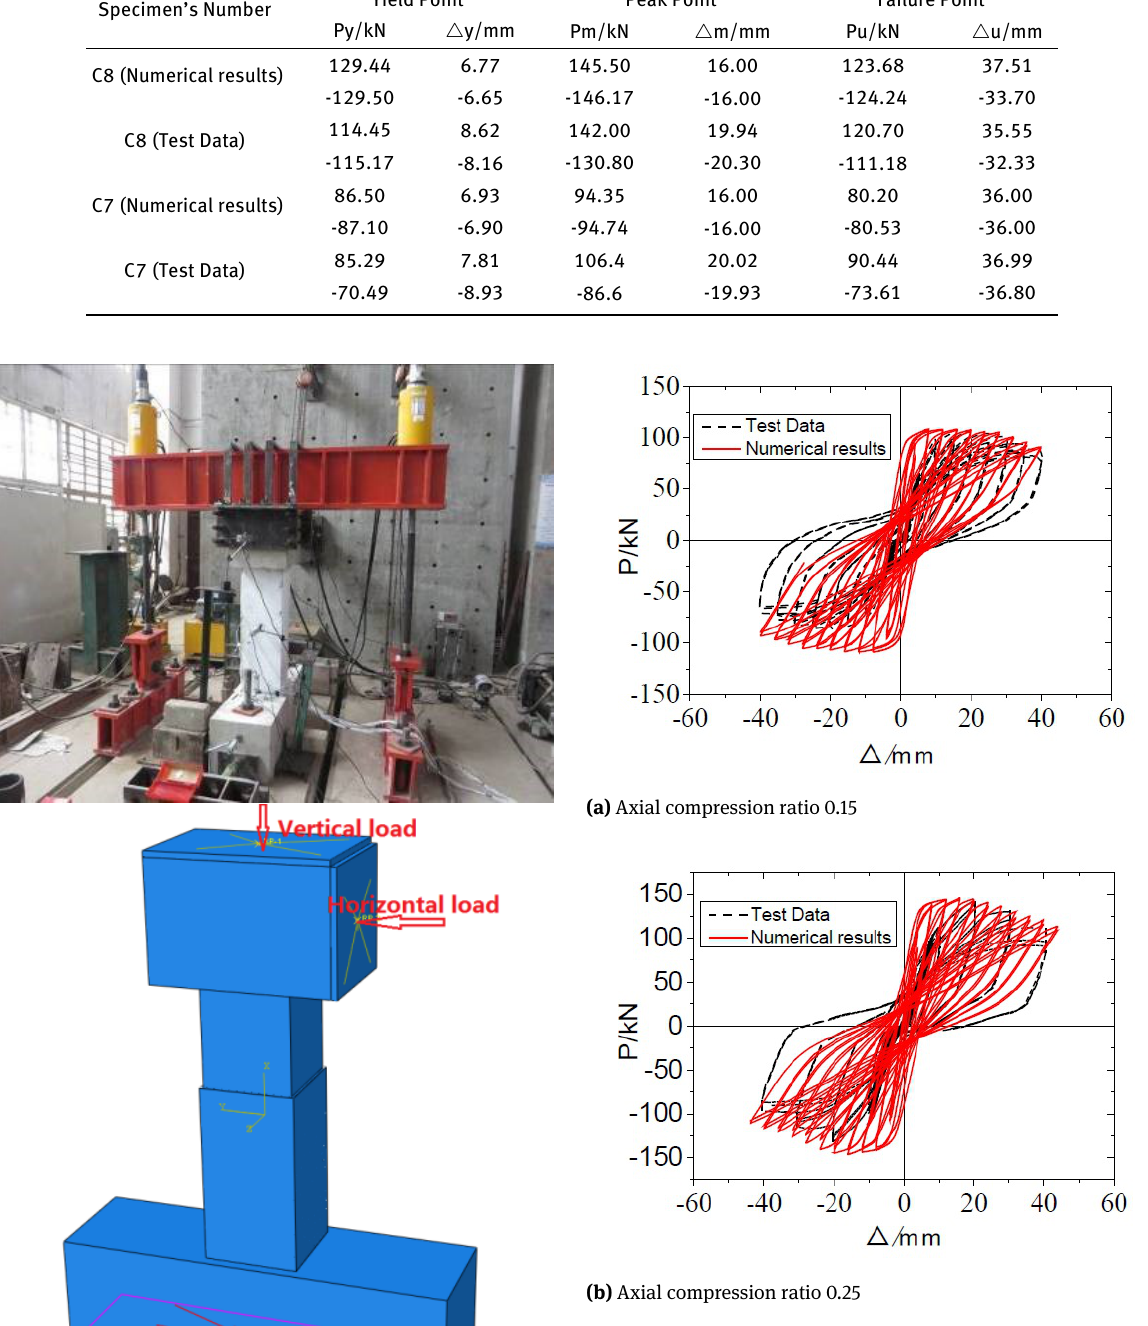
Figure 4: Hysteresis curves of concrete